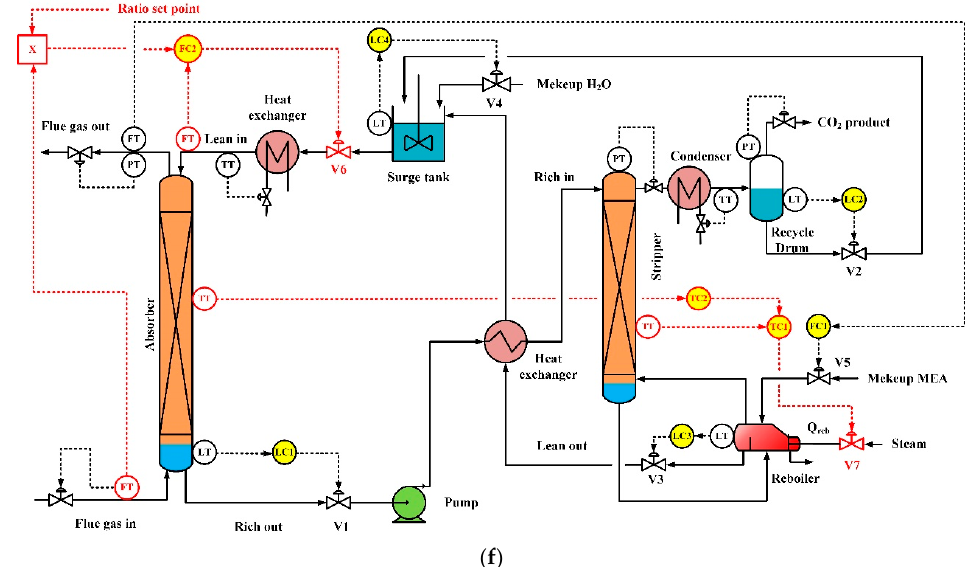
Figure 3. Control schemes proposed for the PCC process where scheme ( a ) is a typical one and schemes ( b – f ) are based on optimal operation conditions. The inventory control loops are the same in all control schemes. The two quality control loops in each control scheme are shown in red. The disturbances of ± 10% around base load case are studied. ( a ) CC-T str ; ( b ) LG-CC; ( c ) LG-LL; ( d ) LG-T abs ; ( e ) LG-T str ; ( f ) LG-T abs -Cascade. LG: liquid to gas ratio; T str : the temperature of a stage of a stripper; T abs : the temperature of a stage of the absorber.